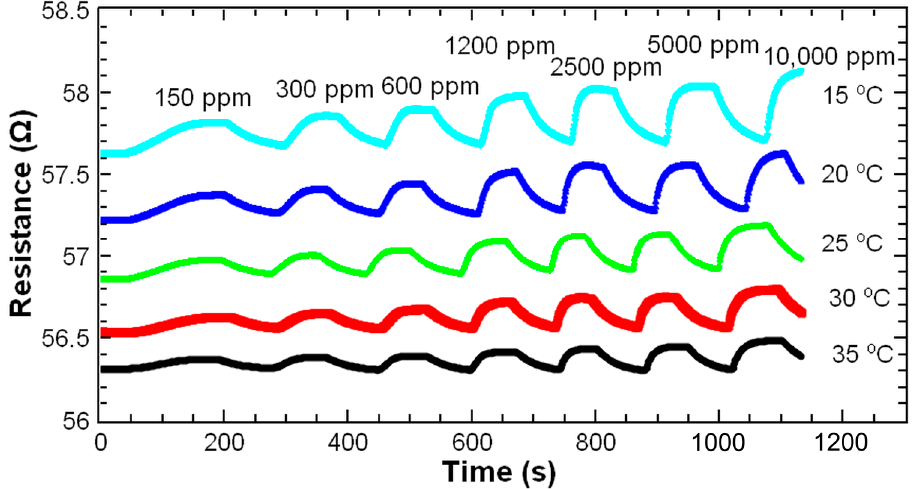
Figure 4. Temporal variation of sensor resistance caused by a change of CO 2 concentration at five constant temperatures.